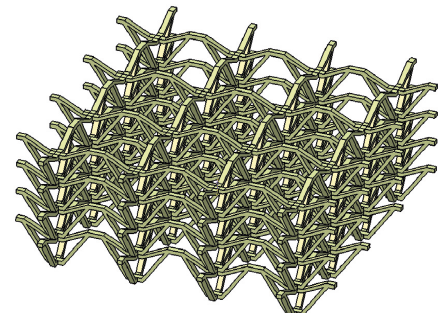
Figure 1: 3D double-arrow negative Poisson’s ratio structure.